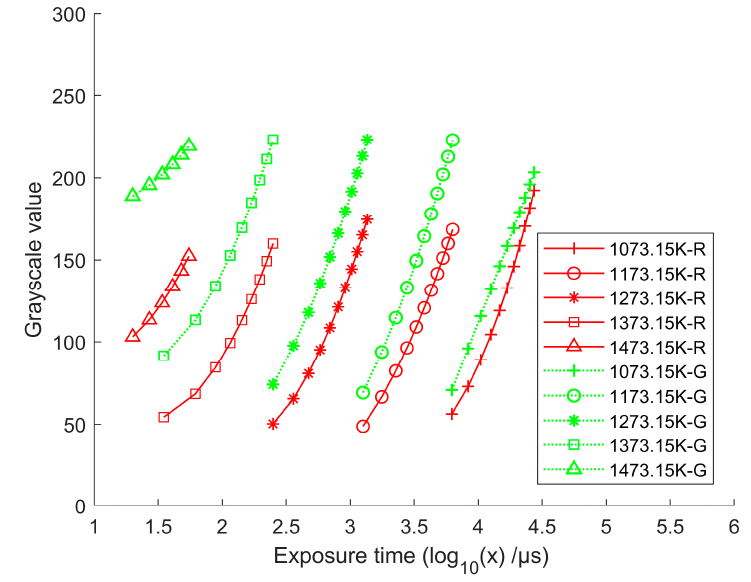
Figure 3. Fitting curves of monochromatic gray value and exposure time at different furnace temperatures.